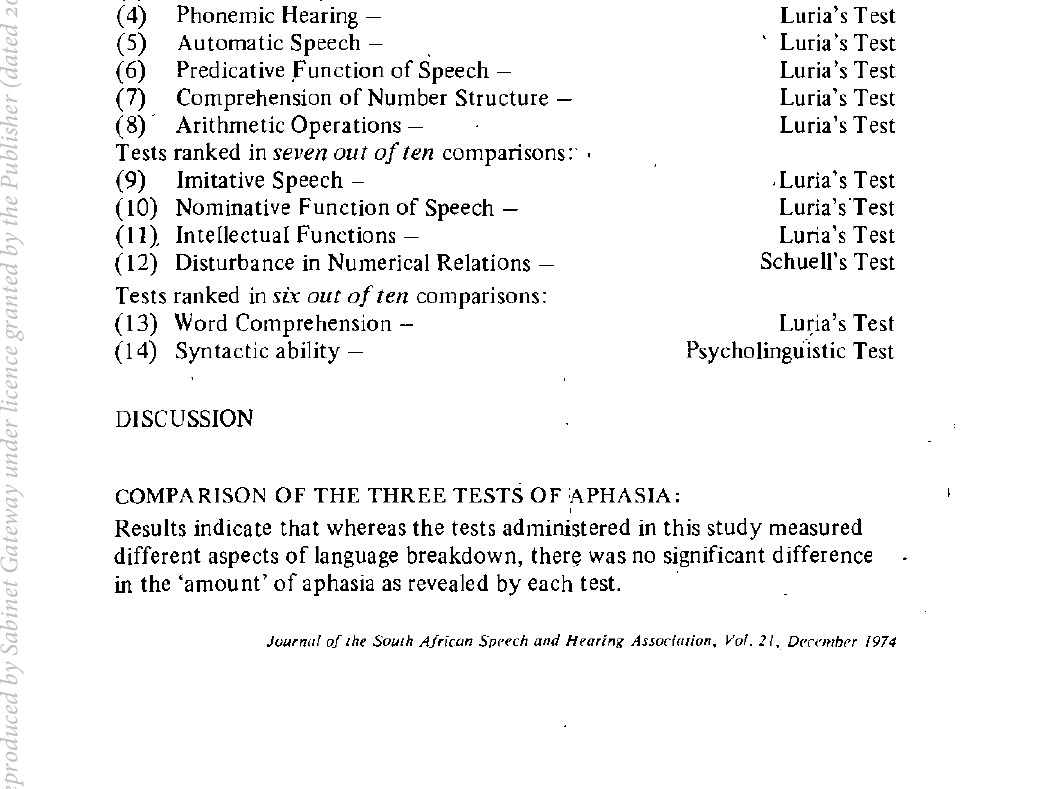
TABLE Ii. Summary of results of performance of subjects on each of the